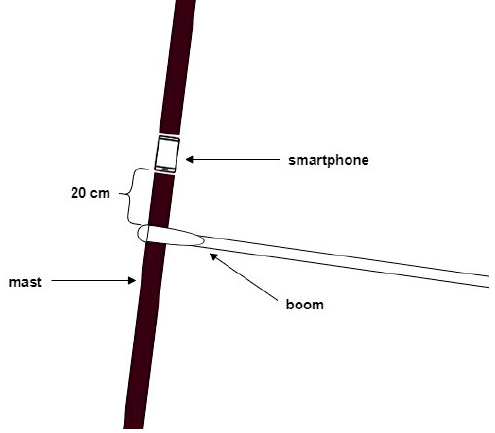
Figure 3. Placing the smartphone on the